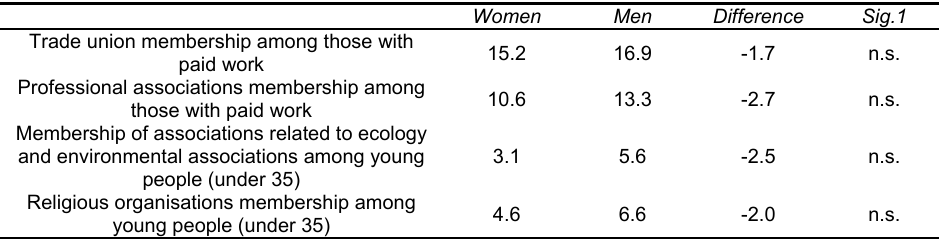
Table 8. Membership percentage of voluntary organisations according to gender, among selected categories of several control